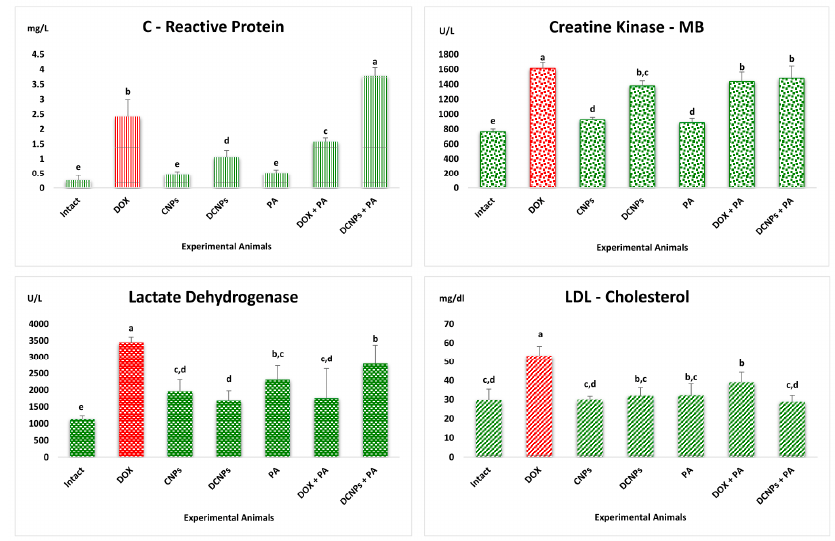
Figure 5. The effect of CNPs and PA on the level of Cardiac Biomarkers (C-Reactive Protein, Creatine Kinase–MB, Lactate Dehydrogenase and LDL Cholesterol) in the serum of experimental animals. Values were expressed as mean ± SD ( n = 5). Bars with different alphabets are significantly different from each other, and bars with same alphabets have insignificant changes ( p < 0.05).